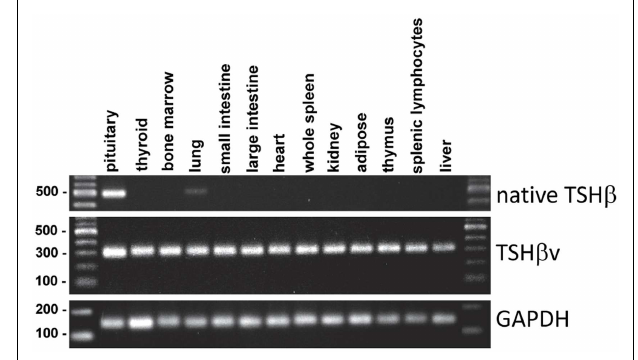
FIGURE 4 |Tissue distribution of nativeTSH β andTSH β v in 13 mouse tissues . Note the restricted expression of nativeTSH β primarily in the pituitary, and the wide distribution ofTSH β v throughout the other